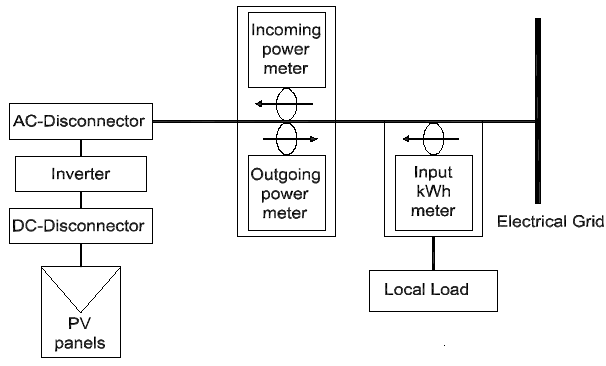
Figure 1. Block diagram of the system.